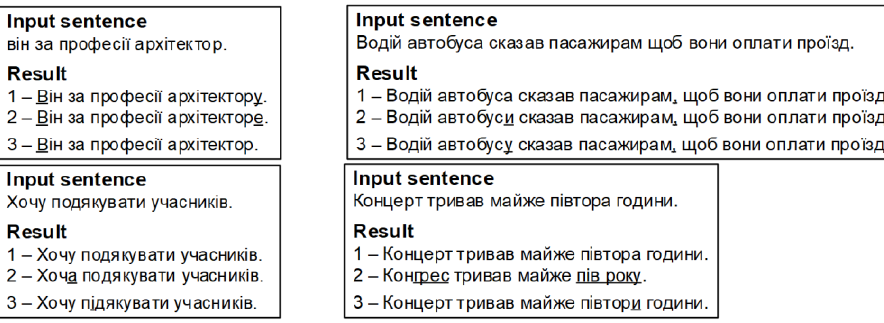
Figure 20. Work of the М2М100 neural network.